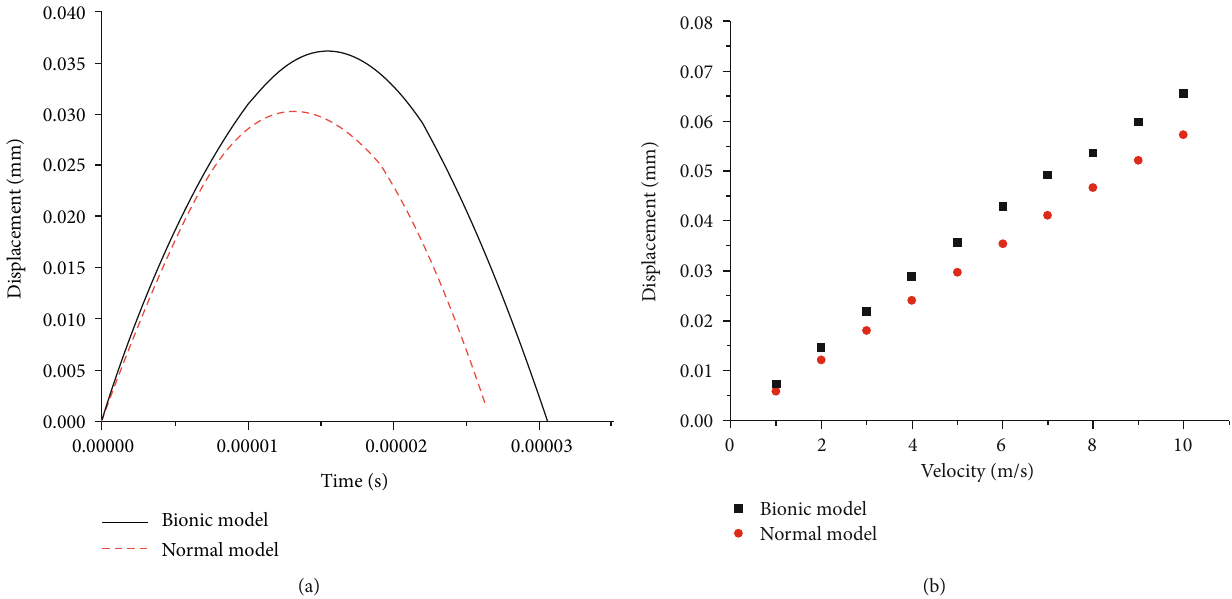
Figure 8: (a) Displacement on the upper surface of the bionic model and the normal model at the loading velocity of 5 m/s; (b) peak displacement on the two models at di ff erent loading